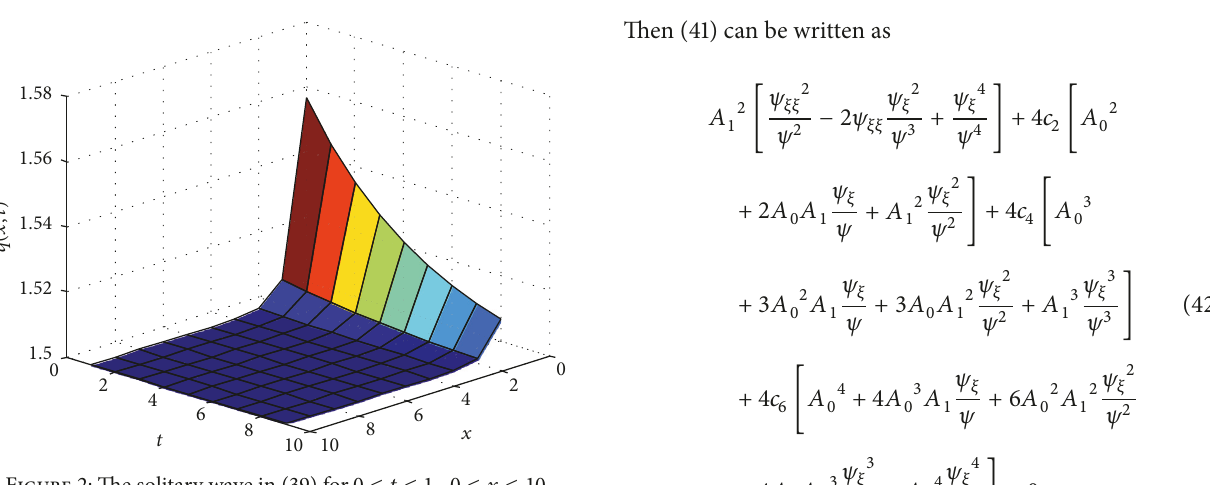
Figure 2: The solitary wave in (39) for 0 ≤ 𝑡 ≤ 1, 0 ≤ 𝑥 ≤ 10